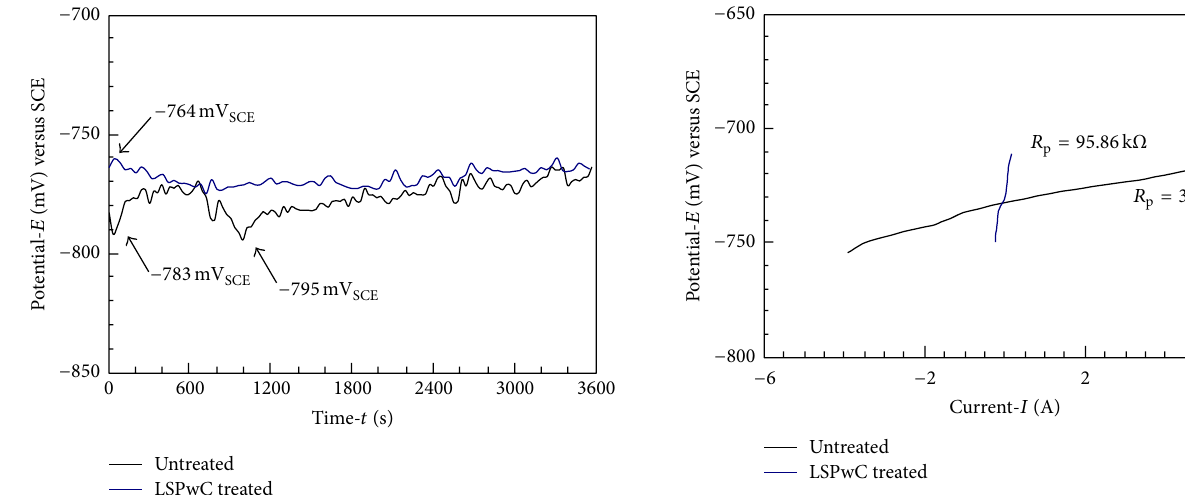
Figure 5: Open circuit potential (𝐸 ocp = 𝑓[𝑡]) curves in 35 g/L NaCl solution.